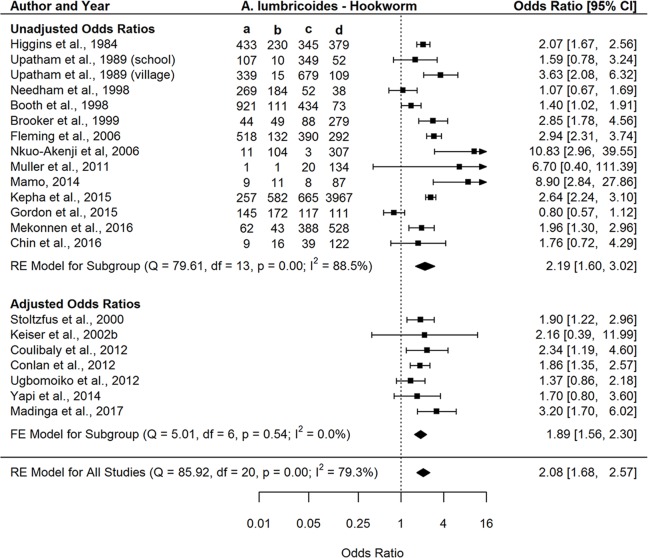
Forest plot of the association between A. lumbricoides and hookworm infections stratified by studies reporting unadjusted and adjusted odds ratios.a = AL+/HW+; b = AL+/HW-; c = AL-/HW+; d = AL-/HW-; RE = random effects. Odds ratio compares the odds of A. lumbricoides infection among hookworm-positive individuals (a/c) to the odds of A lumbricoides infection among hookworm-negative individuals (b/d).